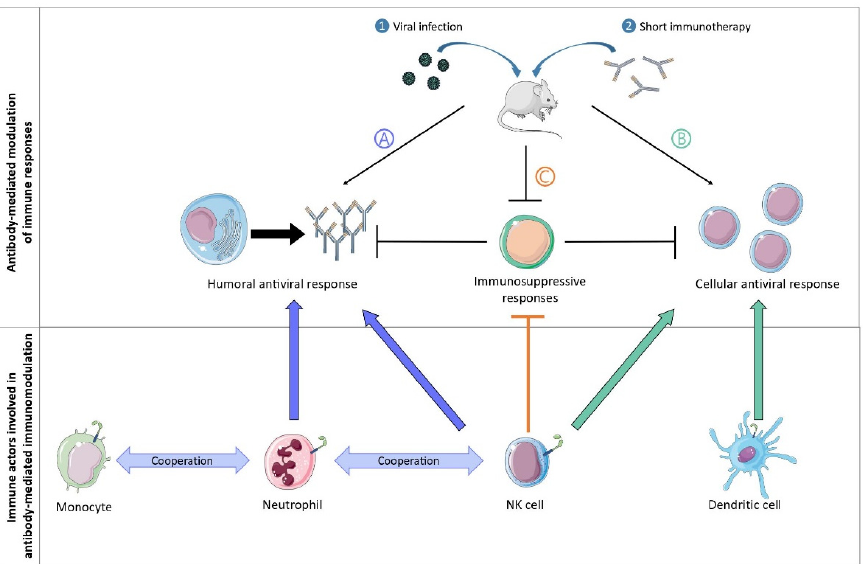
Figure 2. Mechanisms involved in the induction of vaccinal effects. Short treatment of retrovirus- infected mice with a therapeutic monoclonal antibody (mAb) induces a long-term protective response. antiviral response, and (C) the inhibition of immunosuppressive responses (i.e., lack of